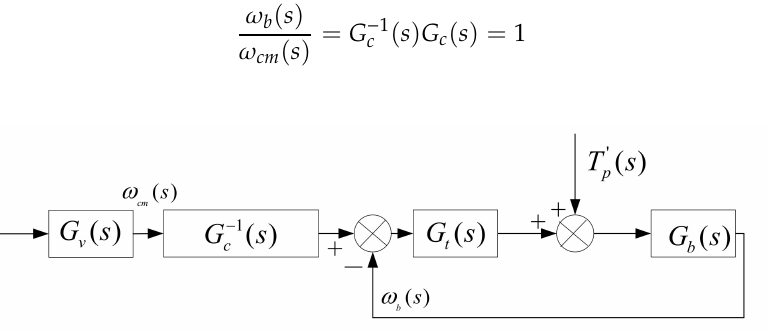
Figure 5. The transfer function diagram after adding the penalty